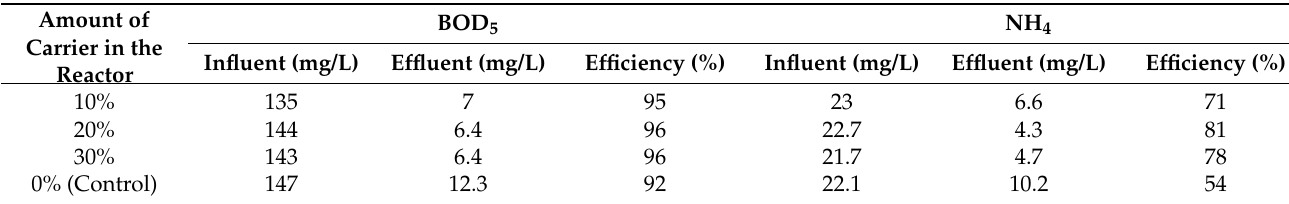
Table 4. Average values of treatment for